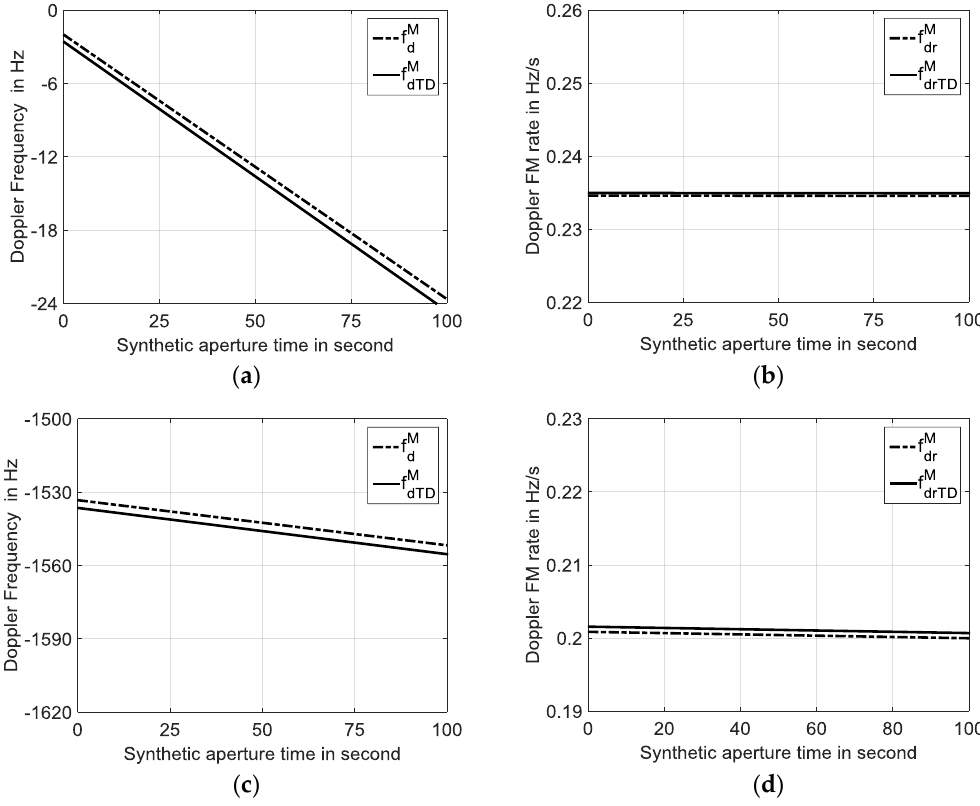
Figure 9. Comparison between the motional Moon-Based SAR with the ‘stop-and-go’ assumption and that without the ‘stop-and-go’ assumption; a g 0 − a m equals 0: ( a ) Doppler frequency; ( b ) Doppler FM rate; with a g 0 − a m equal to π /6; ( c ) Doppler frequency; ( d ) Doppler FM rate.